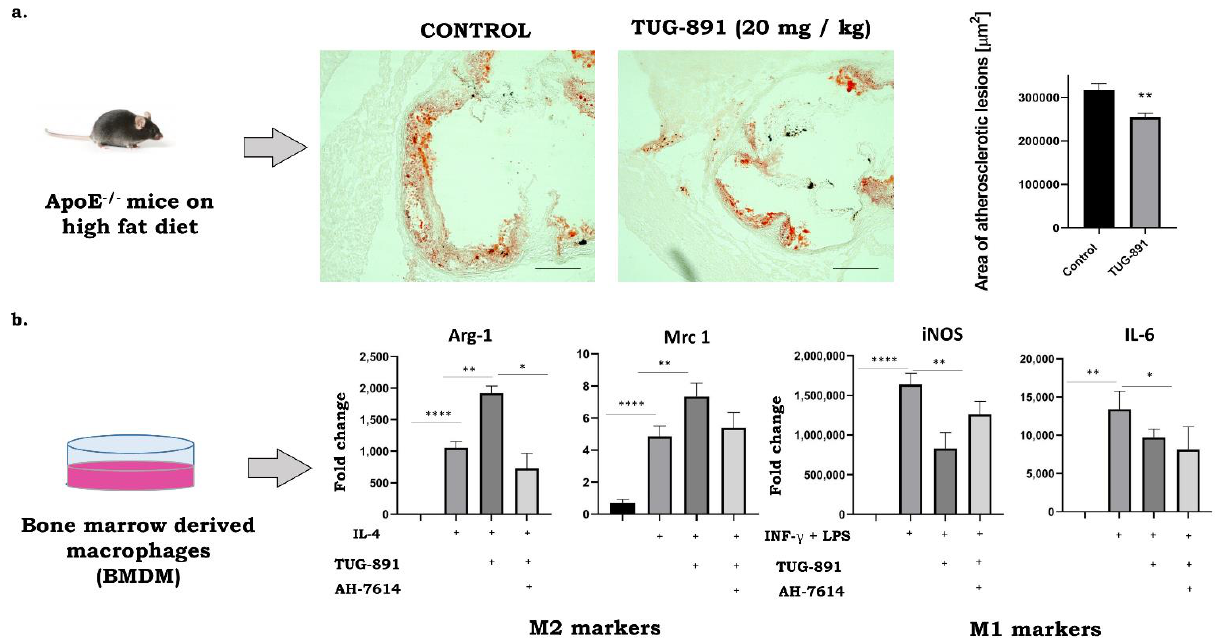
Figure 1. Anti-atherosclerotic activity of TUG-891 in apoE-/- mice. ( a ): The Representative micrographs showing the areas of Oil Red O–stained lesions in control and TUG-891-treated groups (preliminary data of n = 5 per group). ( b ): M1/M2 marker expression in bone marrow derived macrophages (BMDM). BMDMs were pre-treated with either 10 µ M AH-7614 and 10 µ M TUG-891 for 1 h and then treated with 100 ng/mL LPS + 20 ng/mL INF- γ or 20 ng/mL IL-4 for 24 h and then used in quantitative RT-PCR analyses. (* p < 0.05, ** p < 0.01, **** p < 0.0001 as determined by 1-way ANOVA with Tukey’s post-test; n = 3–4 per group; unpublished data).